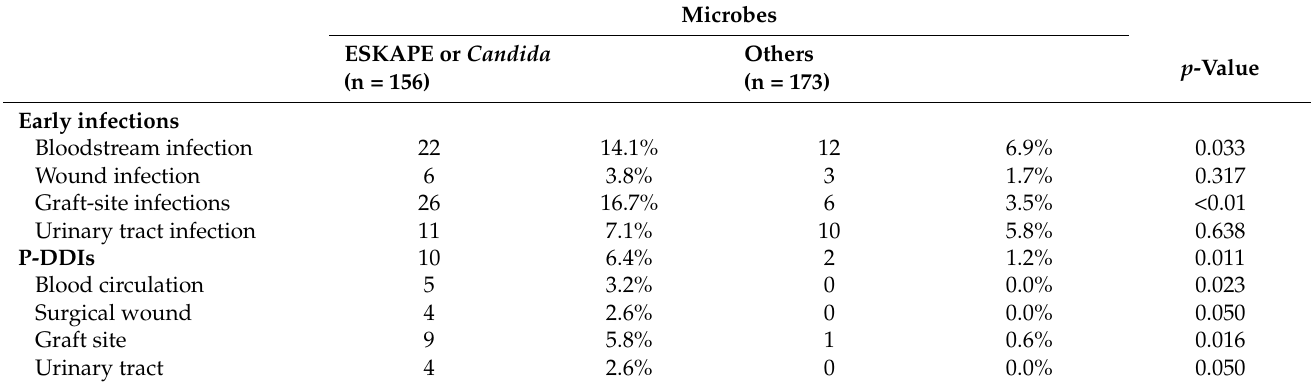
Table 3. Impact of ESKAPE or Candida group in preservation fluid on early infection-related events.